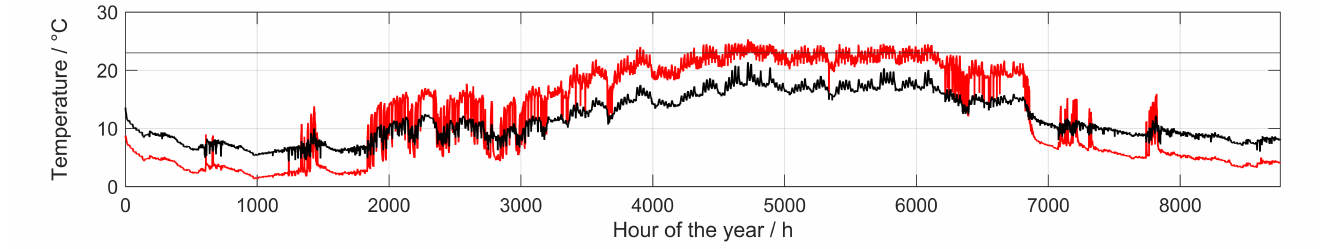
Figure 13. Annual performance of the BTES: Feed (red) and mean outlet temperature (black).